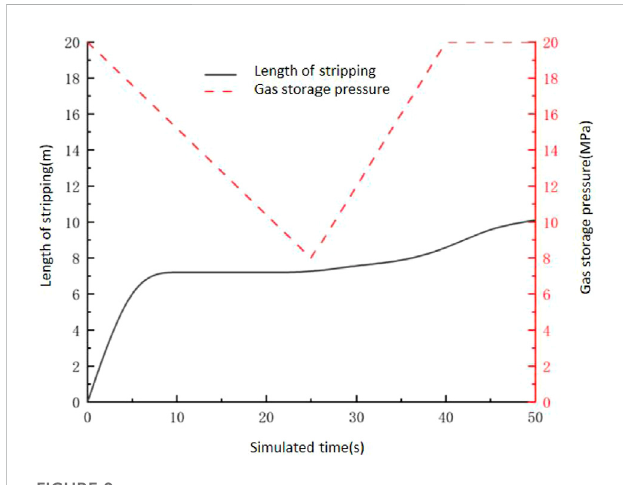
FIGURE 9 Stripping failure length vs. pressure.